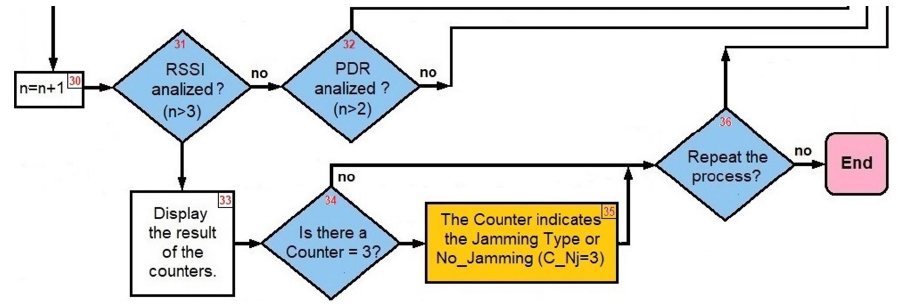
Figure 20. Final